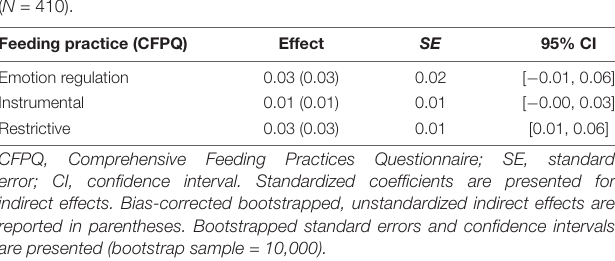
FIGURE 2 | Standardized regression estimates for mother’s conditional effects. * p < 0.05, ** p < 0.001. Covariates included parent stress, parent negative affect, child age, and child gender on all model